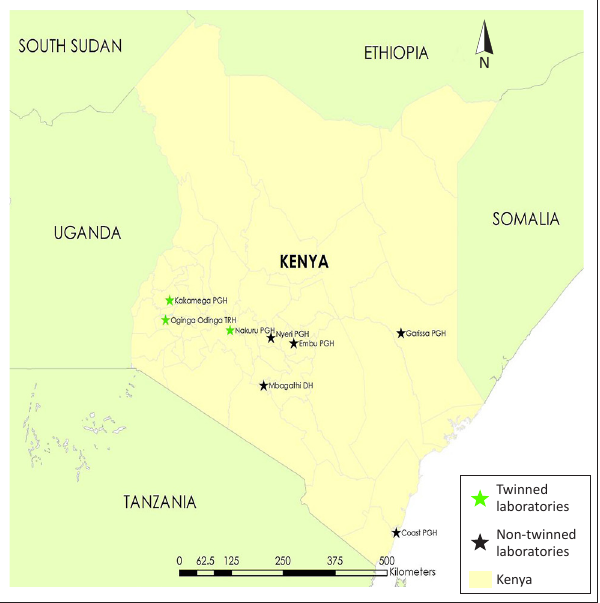
FIGURE 1: Map of Kenya showing the location of regional Strengthening Laboratory Management Toward Accreditation (SLMTA) cohort I